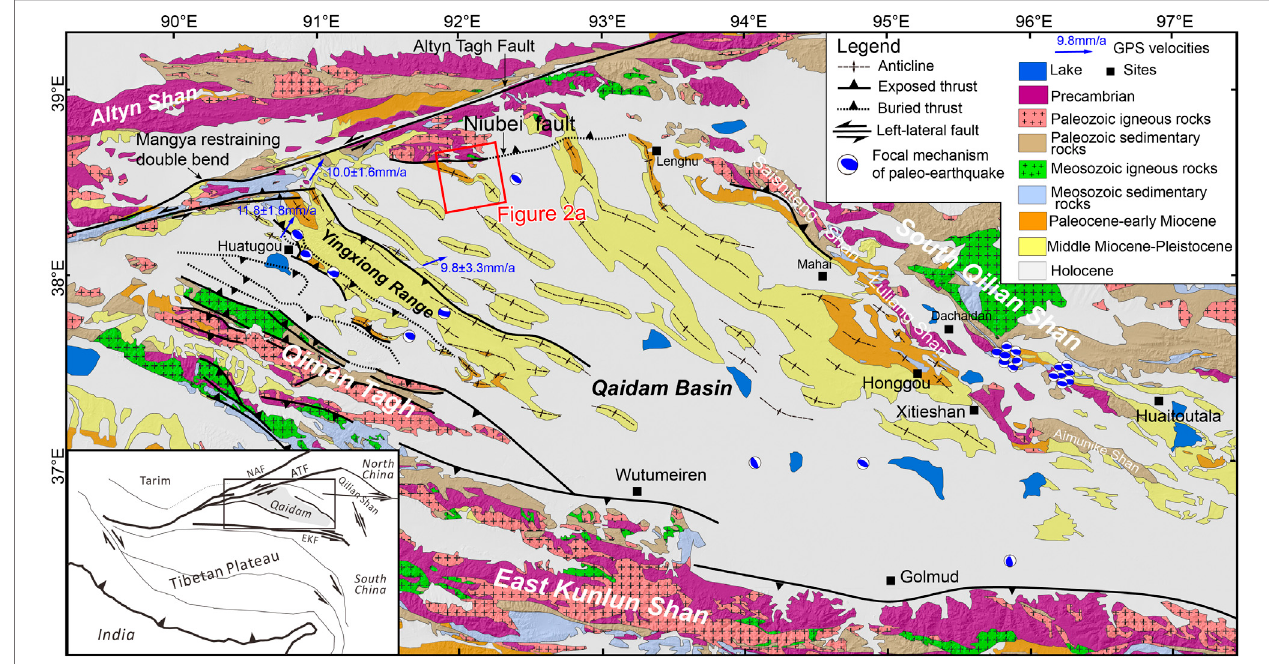
FIGURE1| Simpli fi edgeologicalmapoftheQaidamBasinandadjacentareas,modi fi edfromWeietal.(2016).Itslocationisshownintheinsettectonicmapofthe Tibetan Plateau in the lower-left corner. ATF, Altyn Tagh Fault; EKF, East Kunlun Fault; WK, West Kunlun Mountain; NAF, North Altyn Tagh Fault.